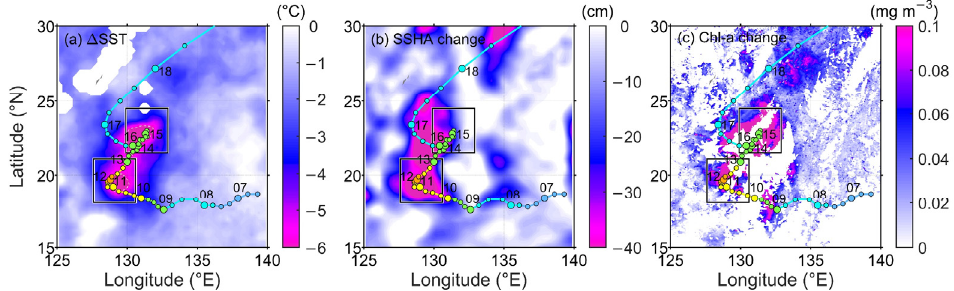
Figure 5. Spatial distribution of the maximum changes in SST, SSHA, and Chl-a concentration induced by the passage of Typhoon Prapiroon. ( a ) The maximum SST cooling; ( b ) the maximum SSHA reduction; and ( c ) the maximum Chl-a concentration increase. Two solid boxes indicate the two focused domains of the sudden-turning stages of the typhoon, denoted A1 and A2. The coloured lines and dots represent the track and intensity of the typhoon. The white dotted lines indicate the − 6 °C isotherm.